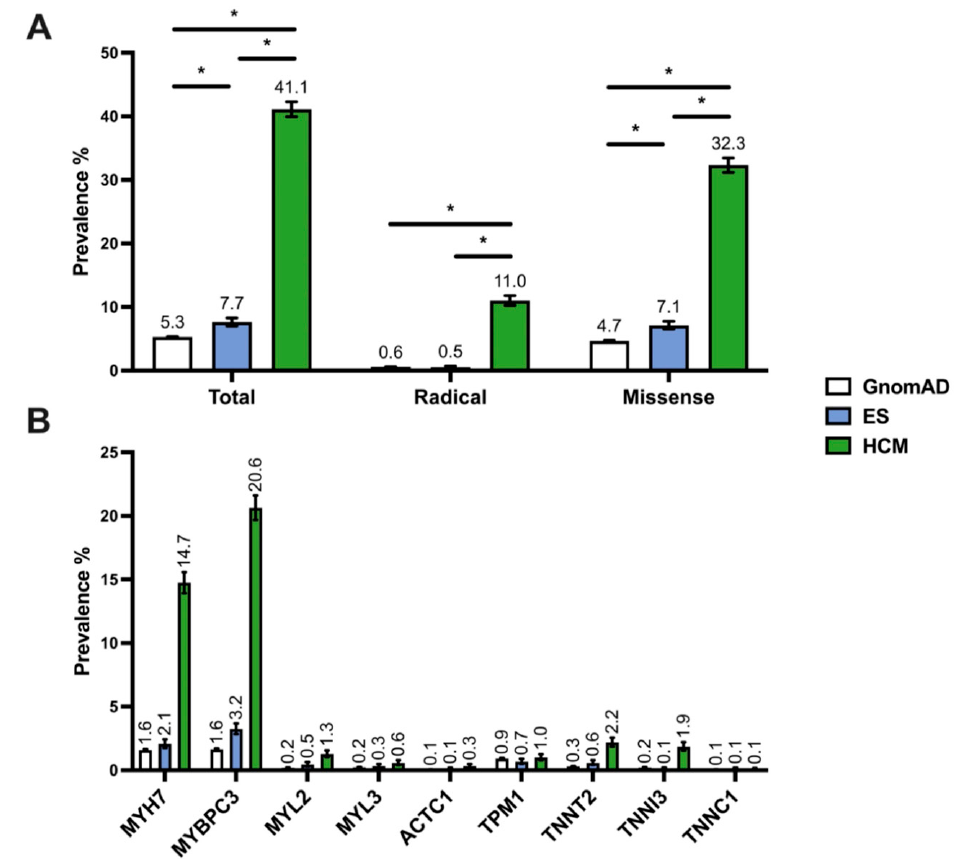
Figure 2. ( A ), Bar graph comparing total, radical, and missense variant frequency of HCM-associated variants. ( B ), Bar graph comparing variant frequency across genes. Comparisons made across a control cohort (gnomAD, white), a cohort of ES referrals (blue), and a cohort of individuals with clinical HCM (green). Error bars denote 95% CI. *, p < 0.05.